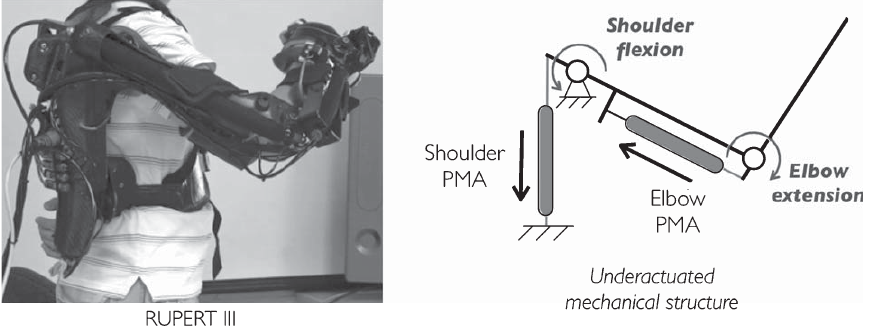
Fig. 1. Picture of RUPERT III (left panel) and a schematic representation of the underactuated design (showing only the shoulder and elbow joints) of the robot (right panel). mechanical structure that is fixed to a static